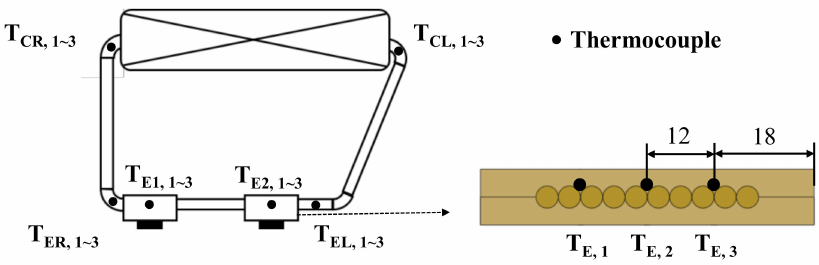
Figure 4. Experimental set up.